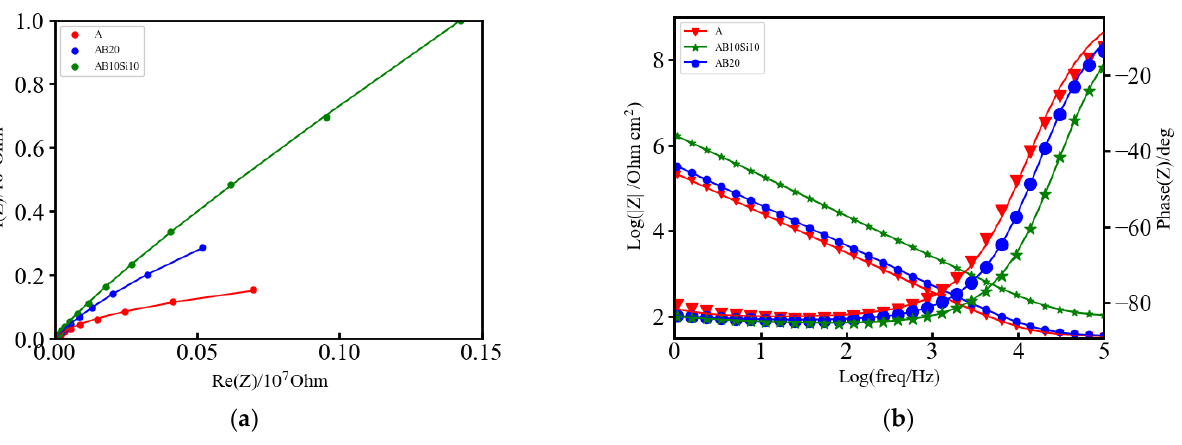
Figure 2. ( a ) Nyquist plot of A, AB20, and AB10Si10 impedance fitted by the equivalent circuit model. Raw data are dots, and the fitting result is represented by lines of the same color and ( b ) Bode plot of A, AB20, and AB10Si10.